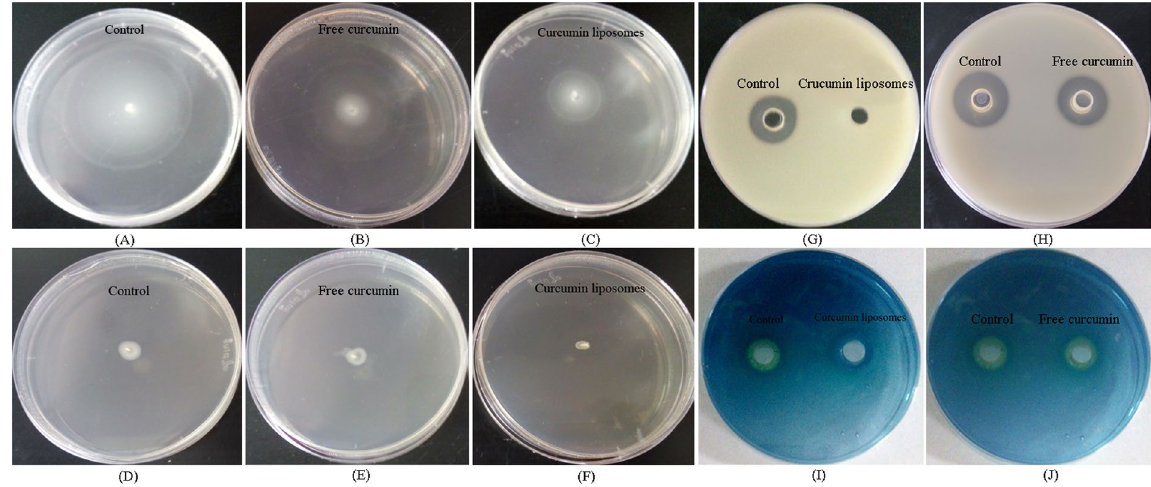
Figure 3. Inhibitory effect of curcumin liposomes and free curcumin (420 µ g/ml of liposomes and 280 µ g/ml of free curcumin) on swimming ( A – C ) and swarming motility ( D – F ), extracellaluar proteases ( G , H ) as well as siderophore ( I , J ) of A. sobria .